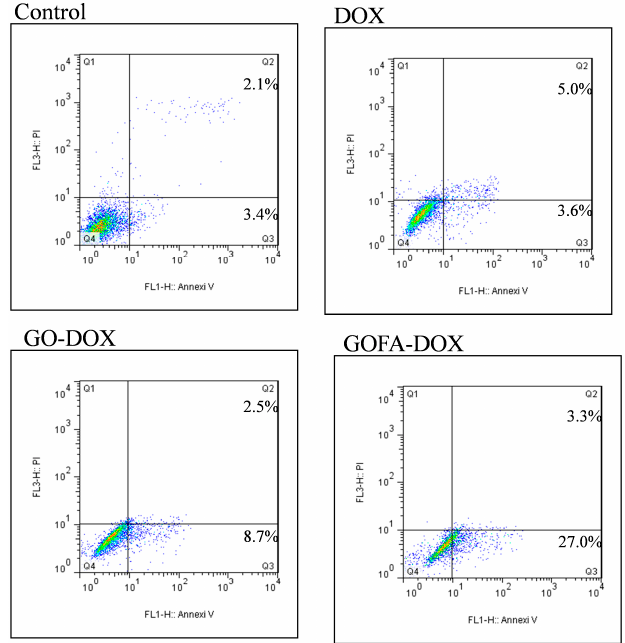
Figure 8. Flow cytometer analysis of the apoptotic and necrotic cells by Annexin V-FITC/PI staining